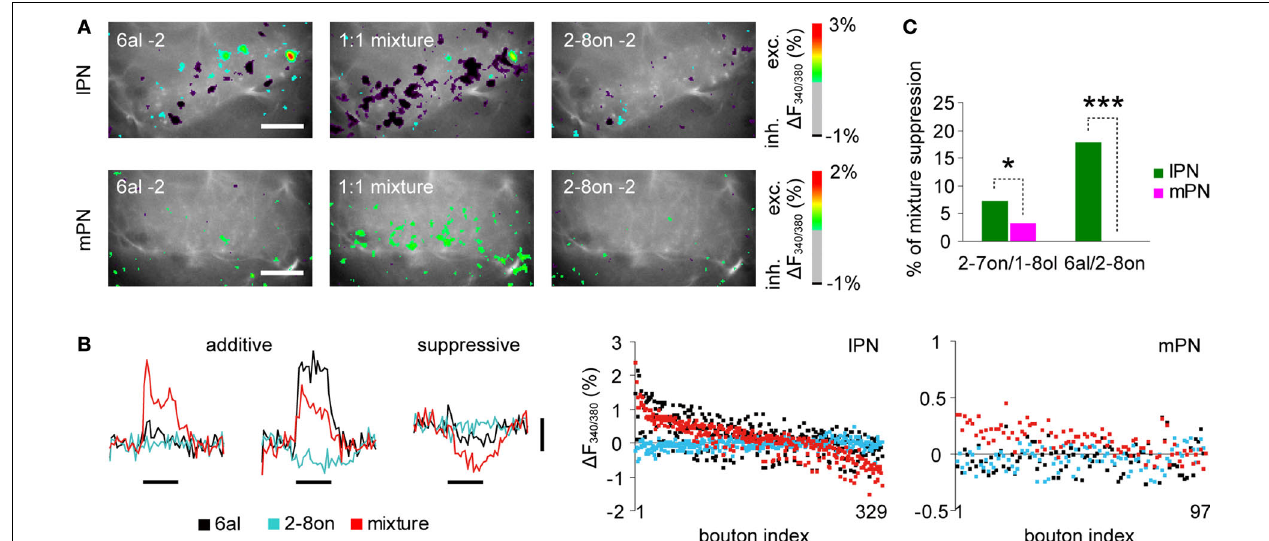
strengths of each bouton for a binary mixture (red dots) and its components (6al: black, 2-8on: cyan) are vertically aligned by different colors. Substantial amount of lPN boutons ( ∼ 30%) exhibited minimum response strengths while mPN boutons mostly exhibited greater or equal response strength to a binary mixture compared to its components. Black bars under the traces indicate the odor stimulus for 3 s. Vertical scale bar: 1% in Δ F . (C) Percentage of boutons 340/380 exhibiting the suppressive mixture effect. In both odor combinations, lPN boutons show greater proportions of mixture suppression than mPN boutons (2- 7on/1-8ol, lPN: 485 boutons, 10 bees, mPN: 347 boutons, 5 bees; 6al/2-8on, lPN: 329 boutons, 6 bees, mPN: 97 boutons, 2 bees, *, p < 0.05, ***, p < 0.001. log- likelihood test applied for absolute bouton